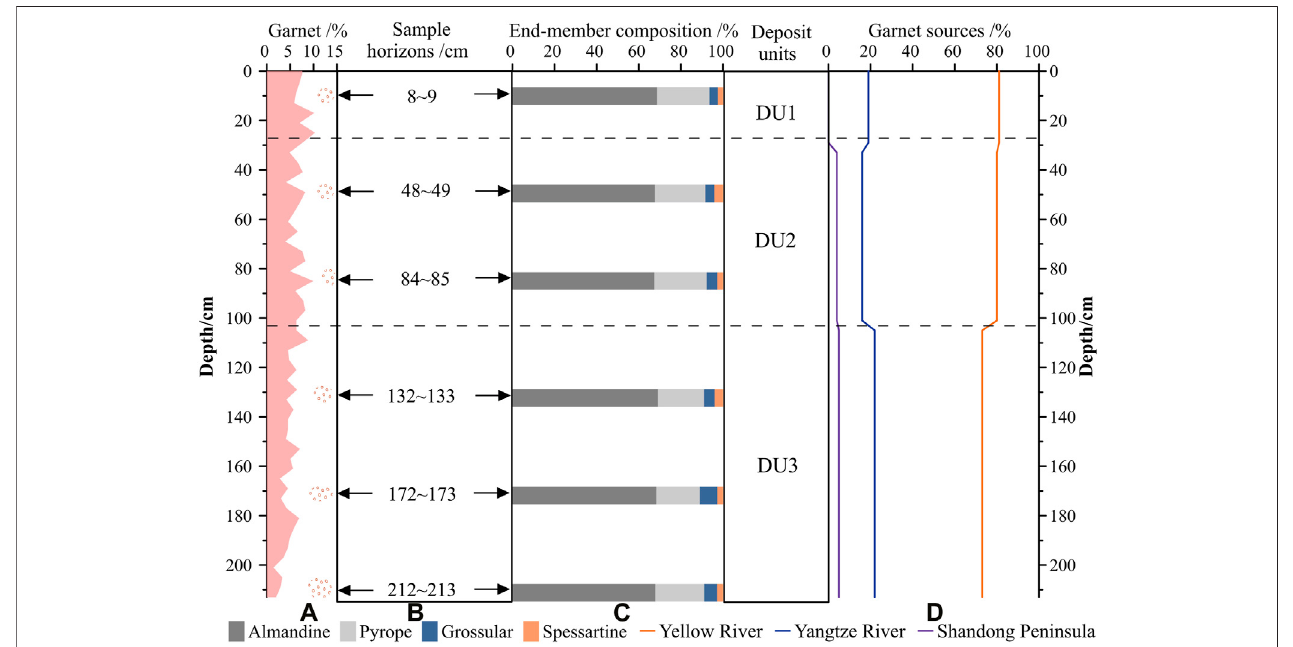
FIGURE 5 | End-member compositions of garnet at six horizons (A – C) of core H10 and the relative contributions of garnet sources (D) in different sedimentary deposit units.